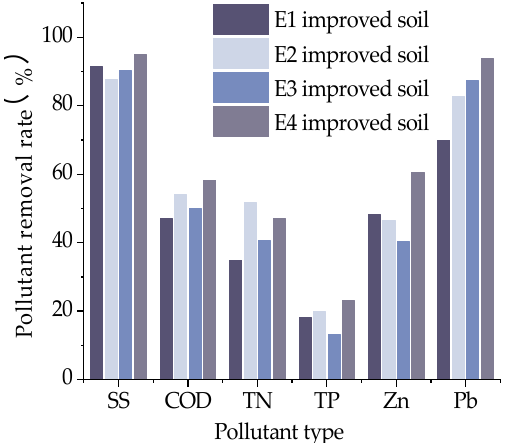
Figure 15. Pollution removal rate of soil amended with the interweaving of ameliorants and structural ameliorants.